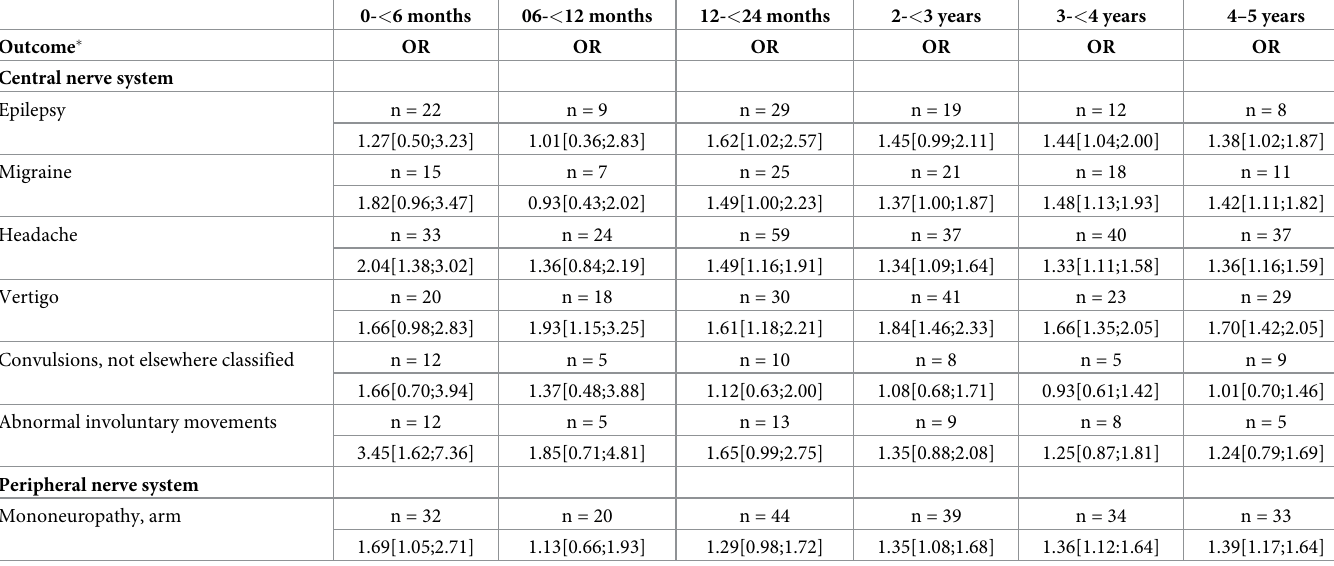
Table 4. Associations between electrical injuries and outcomes for separate time